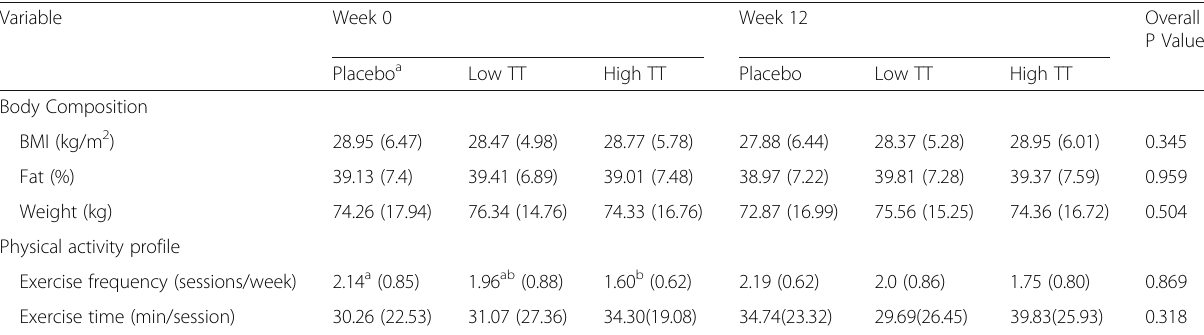
Table 5 Effect of tocotrienol supplementation on body composition and physical activity in postmenopausal osteopenic women